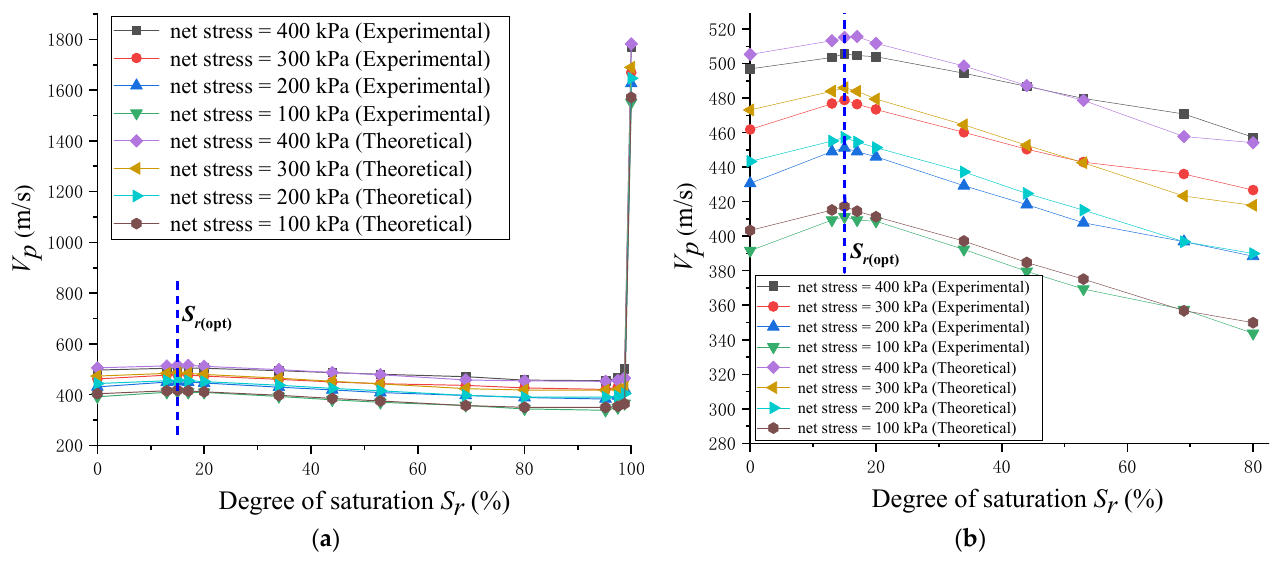
Figure 5. variation in the P-wave velocity with the degree of saturation at different net stresses. ( a ): Saturation range is 0~100%; ( b ): Saturation range is 0~80%.